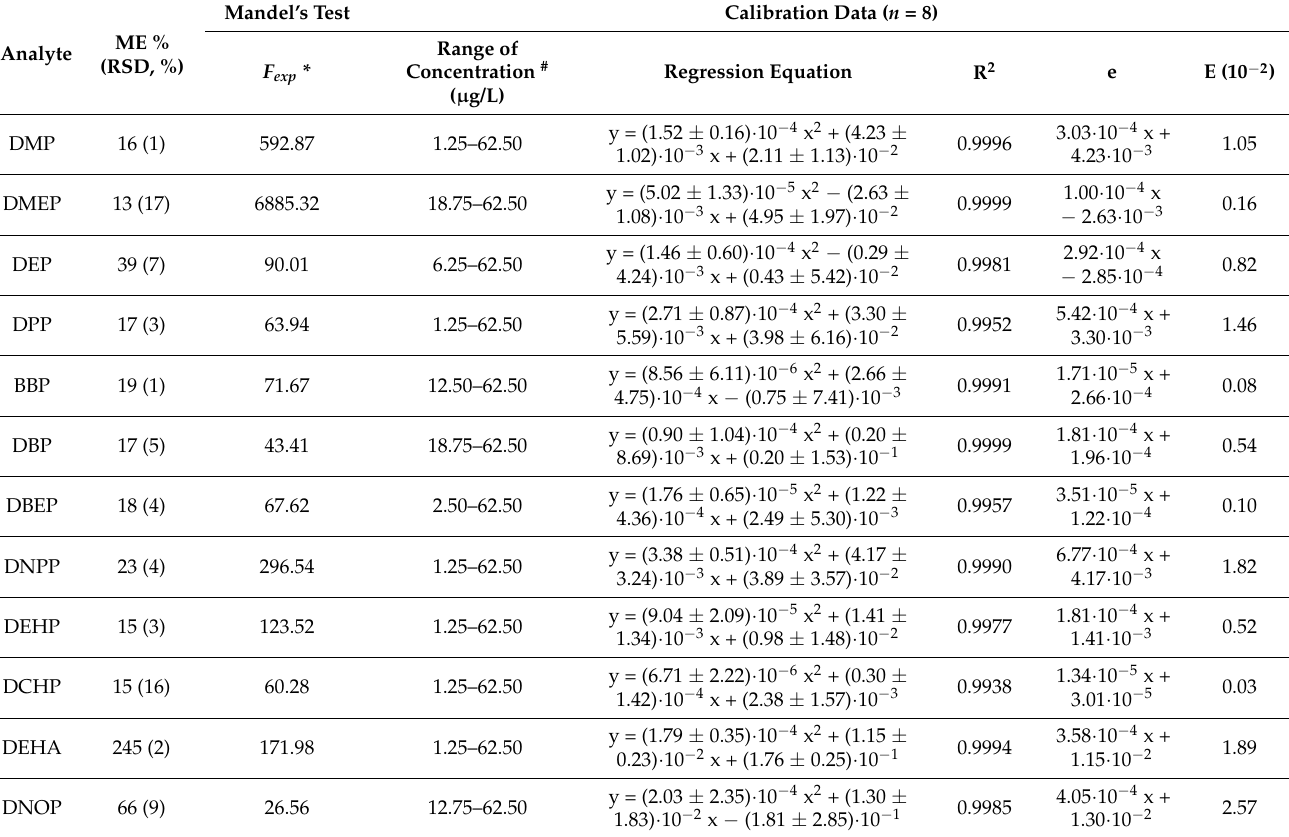
Table 1. Matrix effect (ME), Mandel’s test and matrix-matched calibration data (area/area IS vs. concentration) for the selected PAEs and